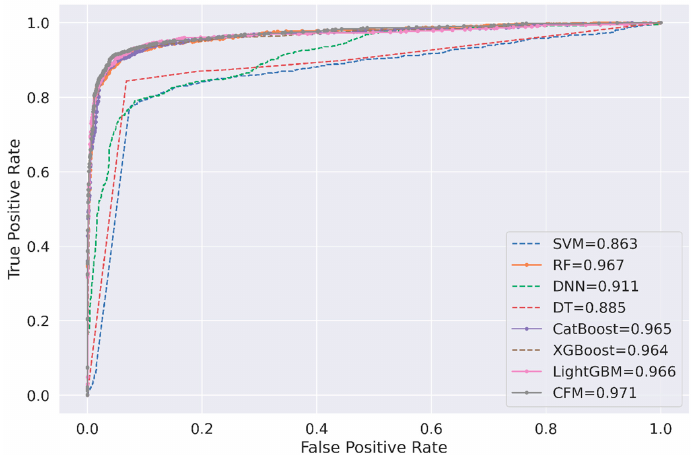
Figure 10. A comparison of the ROC curves and AUC values of different FSM models using the test dataset. Support Vector Machine (SVM), Random Forest (RF), Deep Neural Network (DNN), Decision Tree (DT), Light Gradient Boosting Machine (LightGBM), Categorical Boosting (CatBoost), Extreme Gradient Boosting (XGBoost), and Cascade Forest Model (CFM).